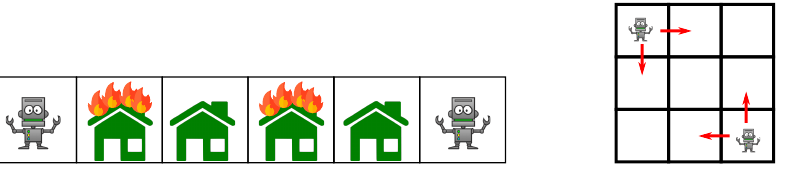
Figure 8. MMDP Problems. ( left ) The fire fighting problem. ( right ) The meeting in grid